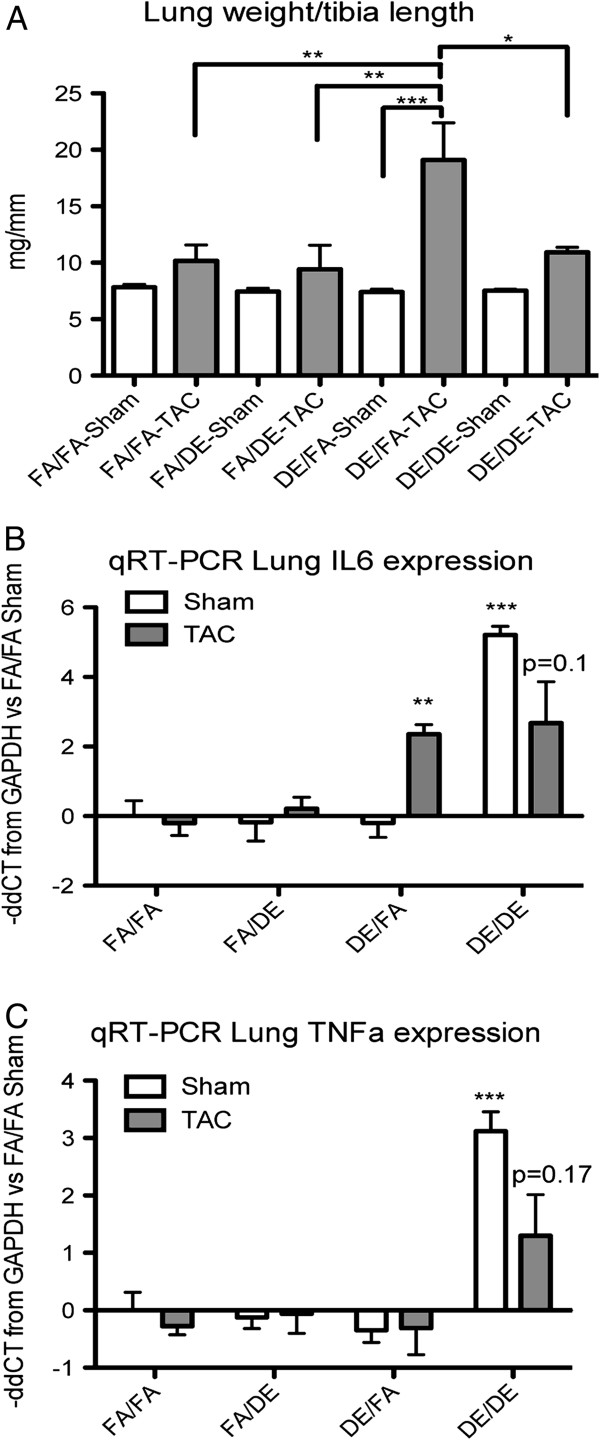
Effects of DE and TAC on lung weight and inflammatory cytokine expression. (A) Lung weights as measured at necropsy were collected and analyzed in FA/FA (n = 7 sham, n = 8 TAC), FA/DE (n = 3 sham, n = 3 TAC), DE/FA (n = 5 sham, n = 5 TAC) and DE/DE (n = 5 sham, n = 4 TAC) groups. Relative real-time PCR analysis of IL6 (B) and TNFα (C) mRNA content in the lung as expressed as negative delta delta CT from FA/FA sham normalized to GAPDH.